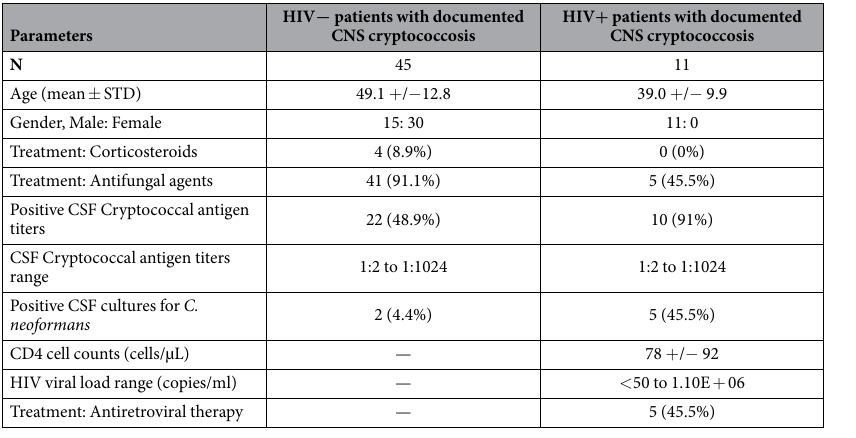
Table 1. Summary of clinical patient